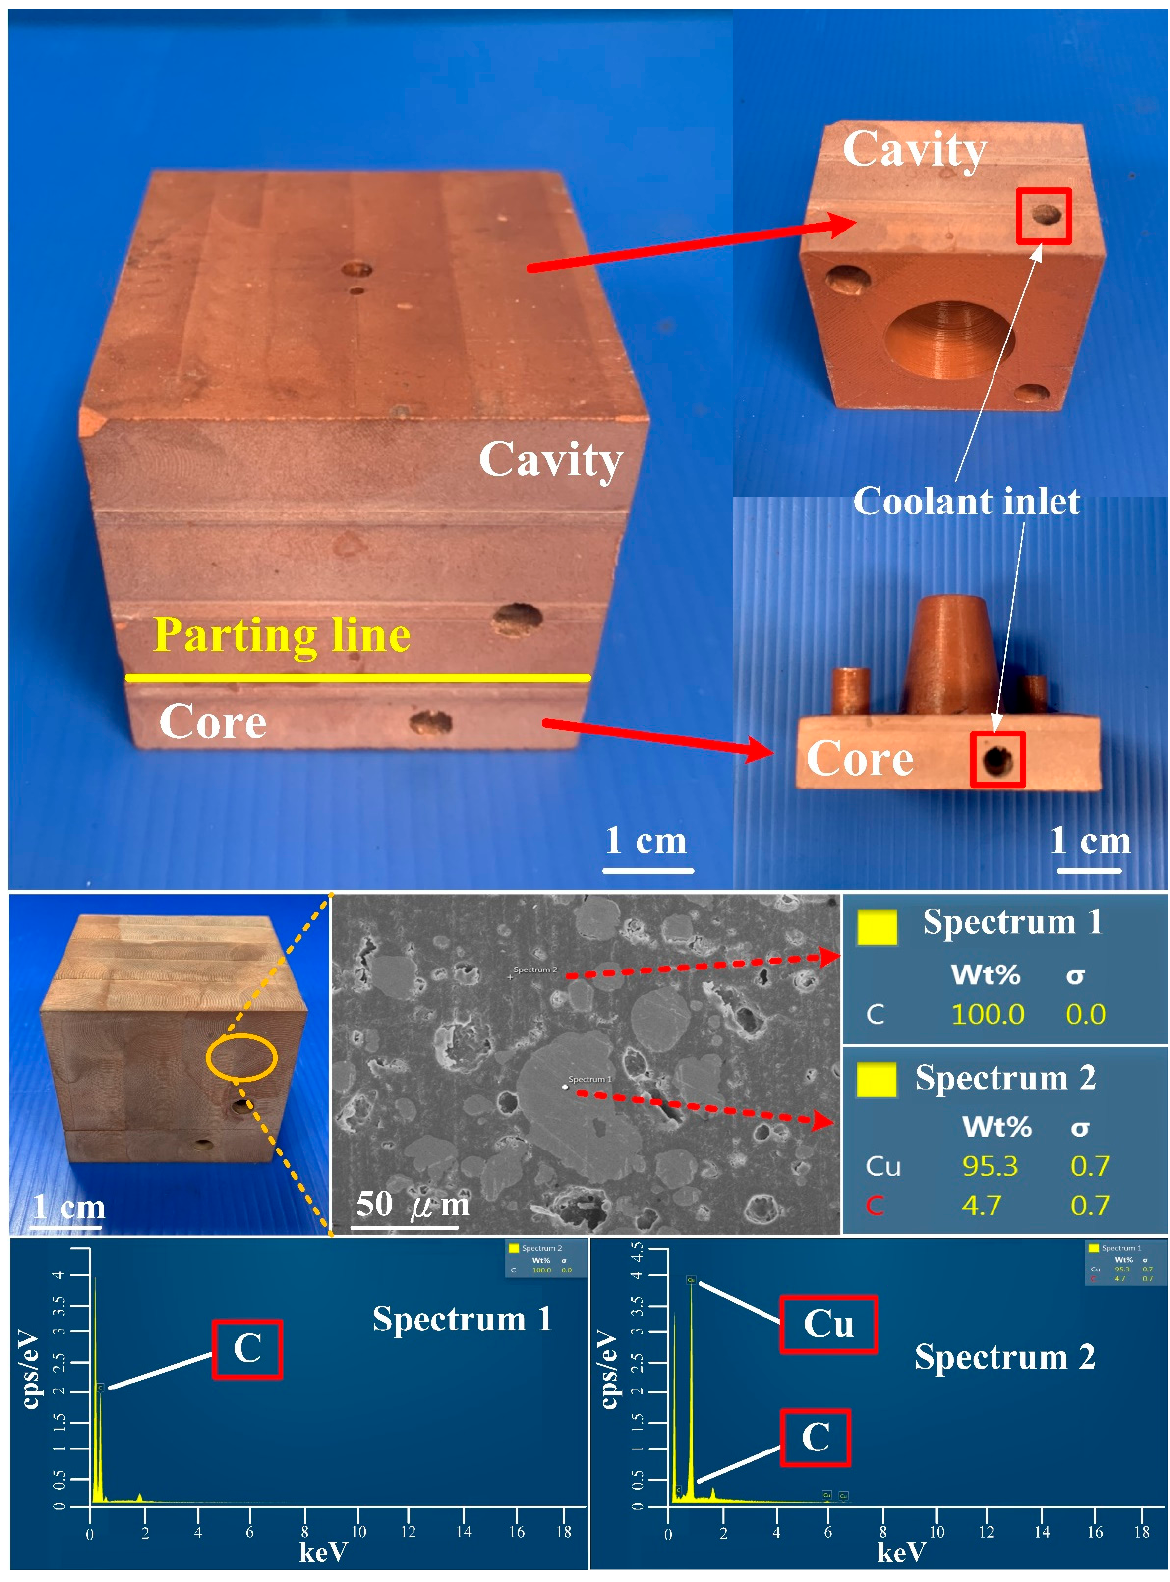
Figure 17. SEM micrographs and chemical composition of wax injection mold fabricated by epoxy resin added with 41 vol.% Cu powder.